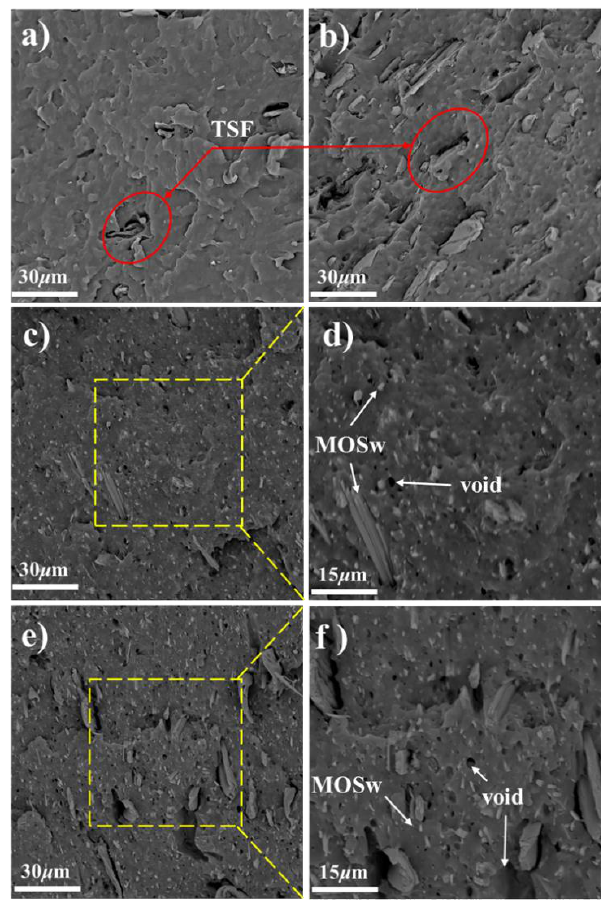
Figure 1. SEM images of samples of B ( a ), C ( b ), D ( c , d ), E ( e , f ).